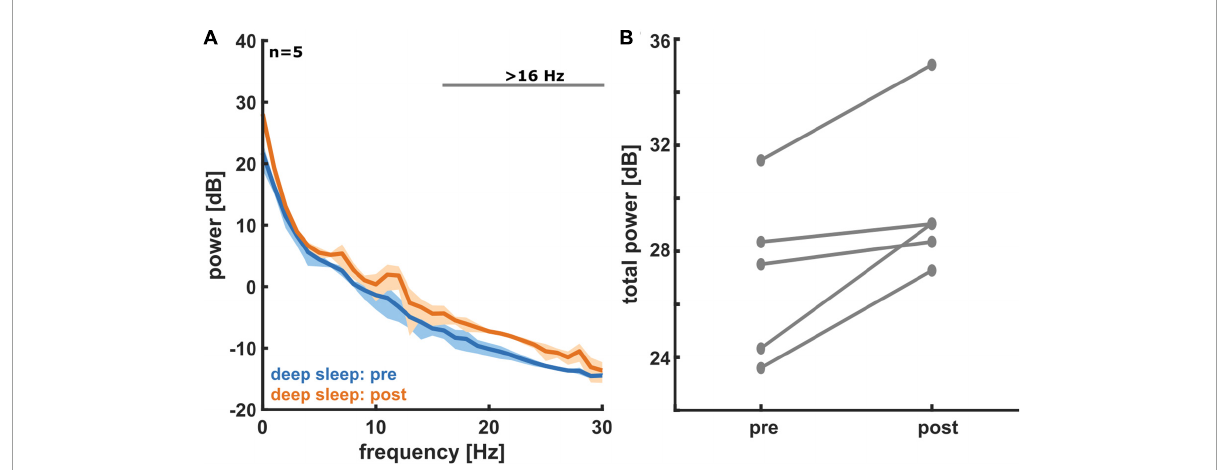
FIGURE4 (A) Power spectral density (PSD) plots for deep sleep, both pre- (blue) and post- (orange) aerobic intervention ( n = 5). A histogram for the measured EEG power in each frequency bin is displayed. Solid lines represent average for all five participants and shading represents 95% confidence interval. In deep sleep we see an increase in EEG power post-exercise, especially at moderate to high frequencies. (B) A comparison of total non-REM EEG power pre- and post-aerobic intervention ( n = 5). For non-REM sleep states (light and deep sleep), we see an increase in total EEG power from pre- to post-aerobic intervention in frontal electrodes. Each pair of connected dots represents a single